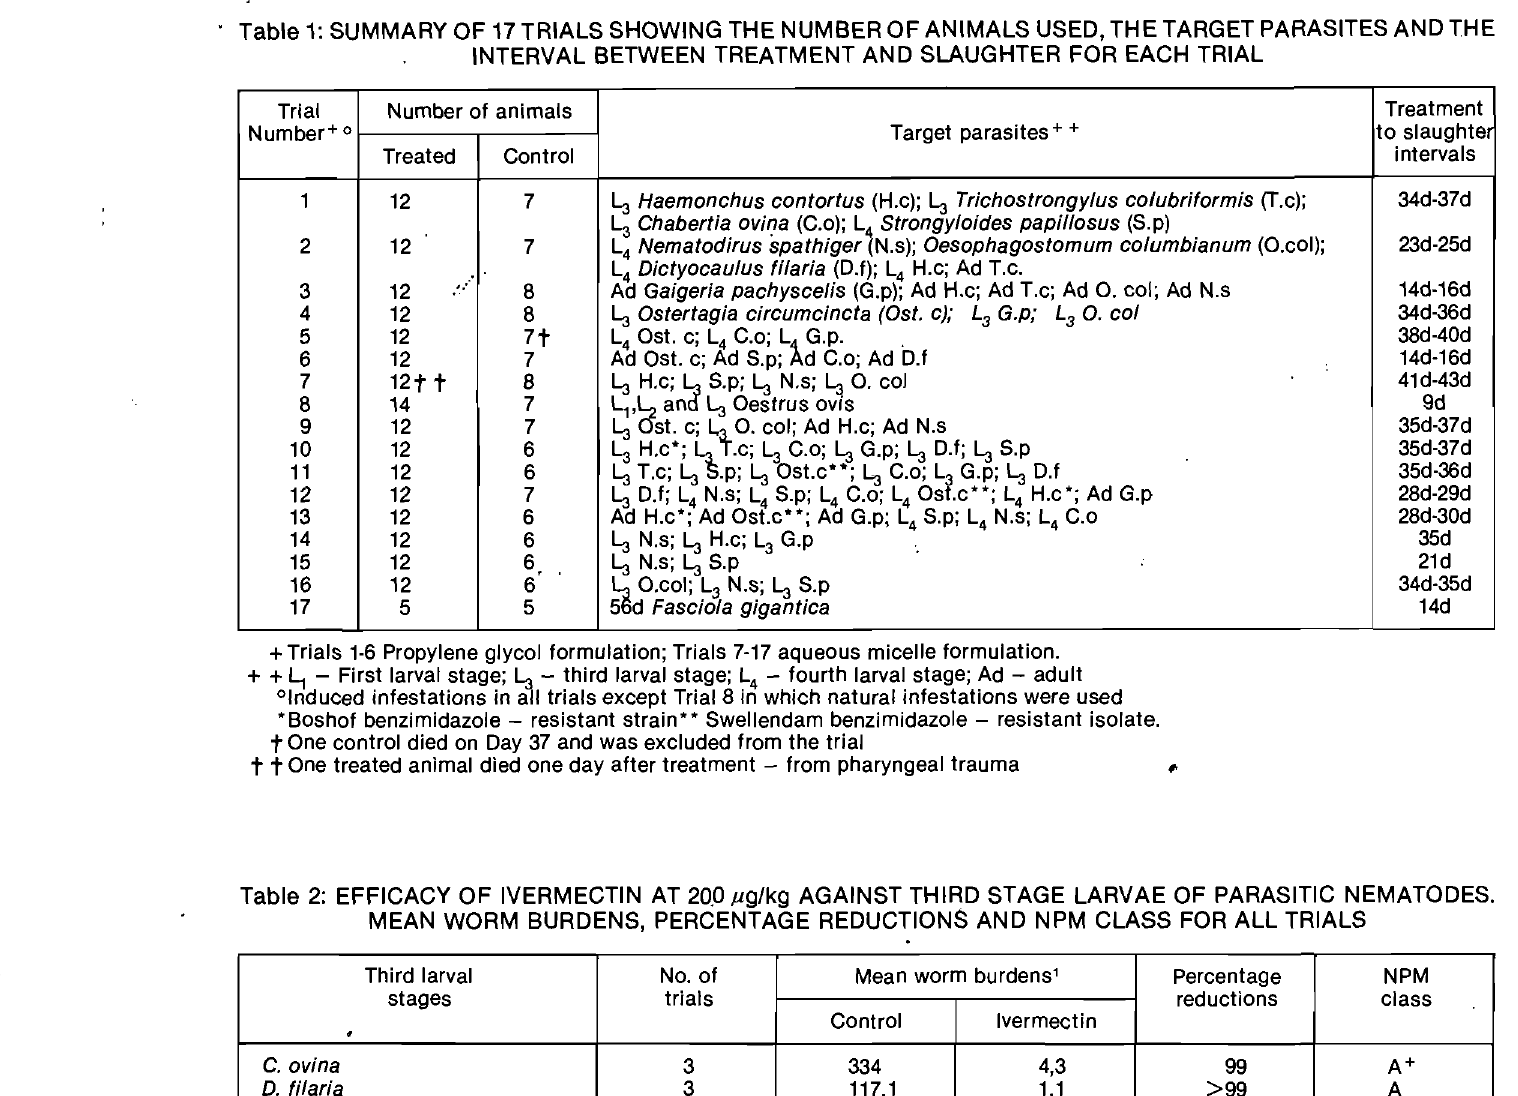
Table 1: SUMMARY OF 17 TRIALS SHOWING THE NUMBER OF ANIMALS USED, THE TARGET PARASITES AND THE INTERVAL BETWEEN TREATMENT AND SLAUGHTER FOR EACH TRIAL Trial Number of animals Number+ ° Target parasites + + Treated Control